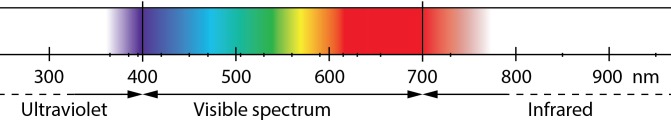
Spectrum of interest (nm).